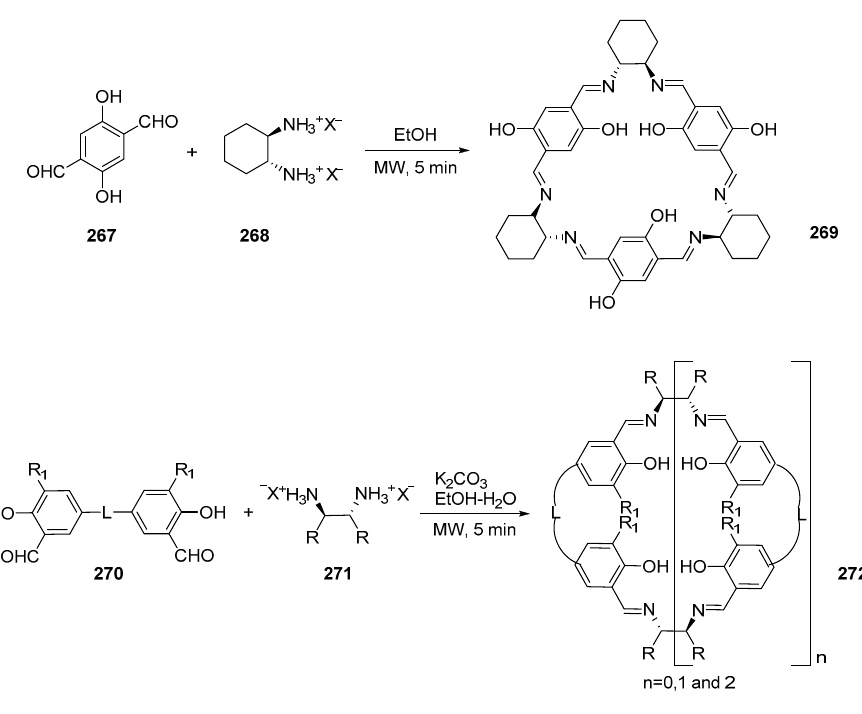
Molecules 2016 , 21 , 1032 38 of